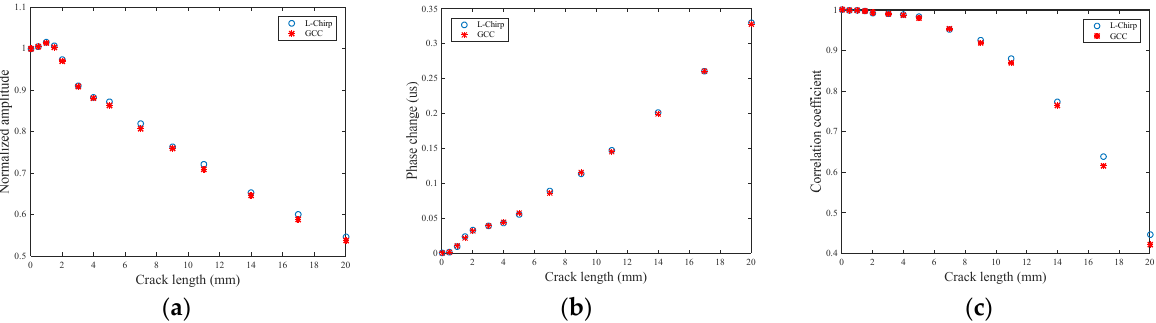
Figure 12. The trends can accord with the physics mechanisms analysis, which manifest that the proposed methods are reasonable.